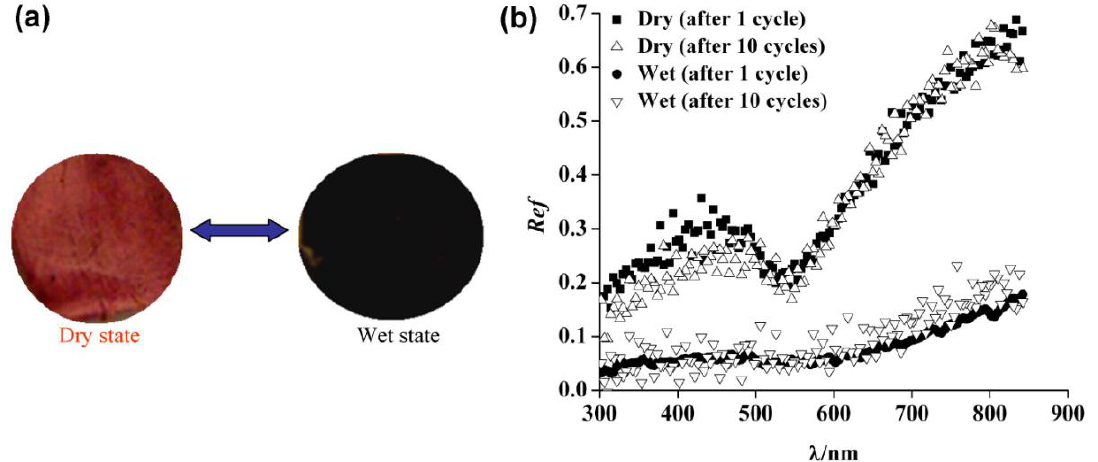
Figure 11. ( a ) Tunable coloration of the surface of the membrane at dry (red) and wet (black) states; ( b ) The reflection spectra of the nanocomposite in dry and wet (completely water soaked) states. (Reprinted with permission from [110] Copyright 2012 Wiley-VCH Verlag GmbH & Co.